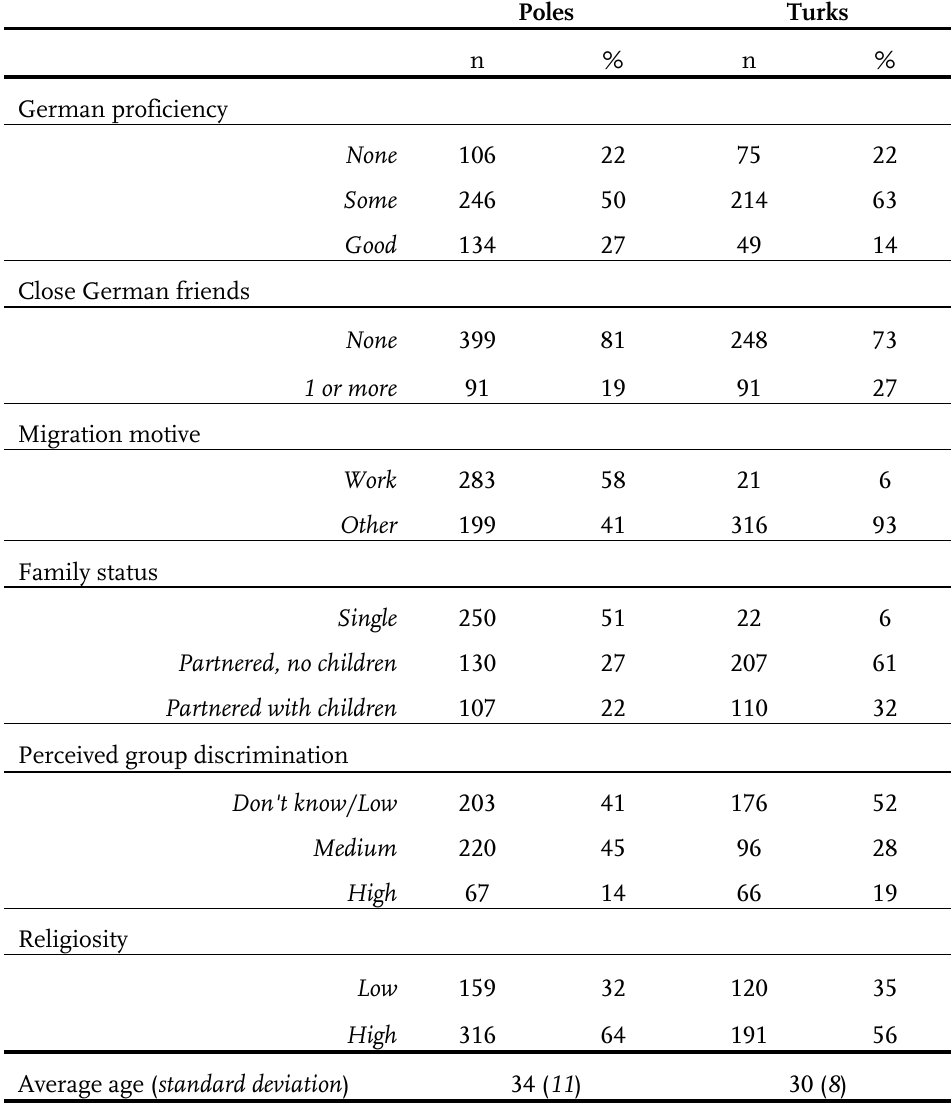
Table 1 : Descriptive statistics of recently-arrived female migrants (column percent) (continued)